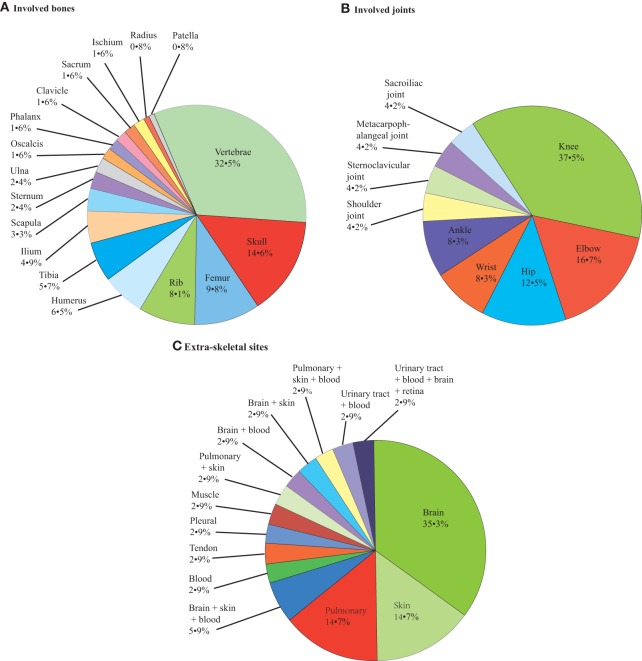
Pie chart of patients' involved bones (A), joints (B) and extra-skeletal sites (C): 123, 24, 34, respectively.